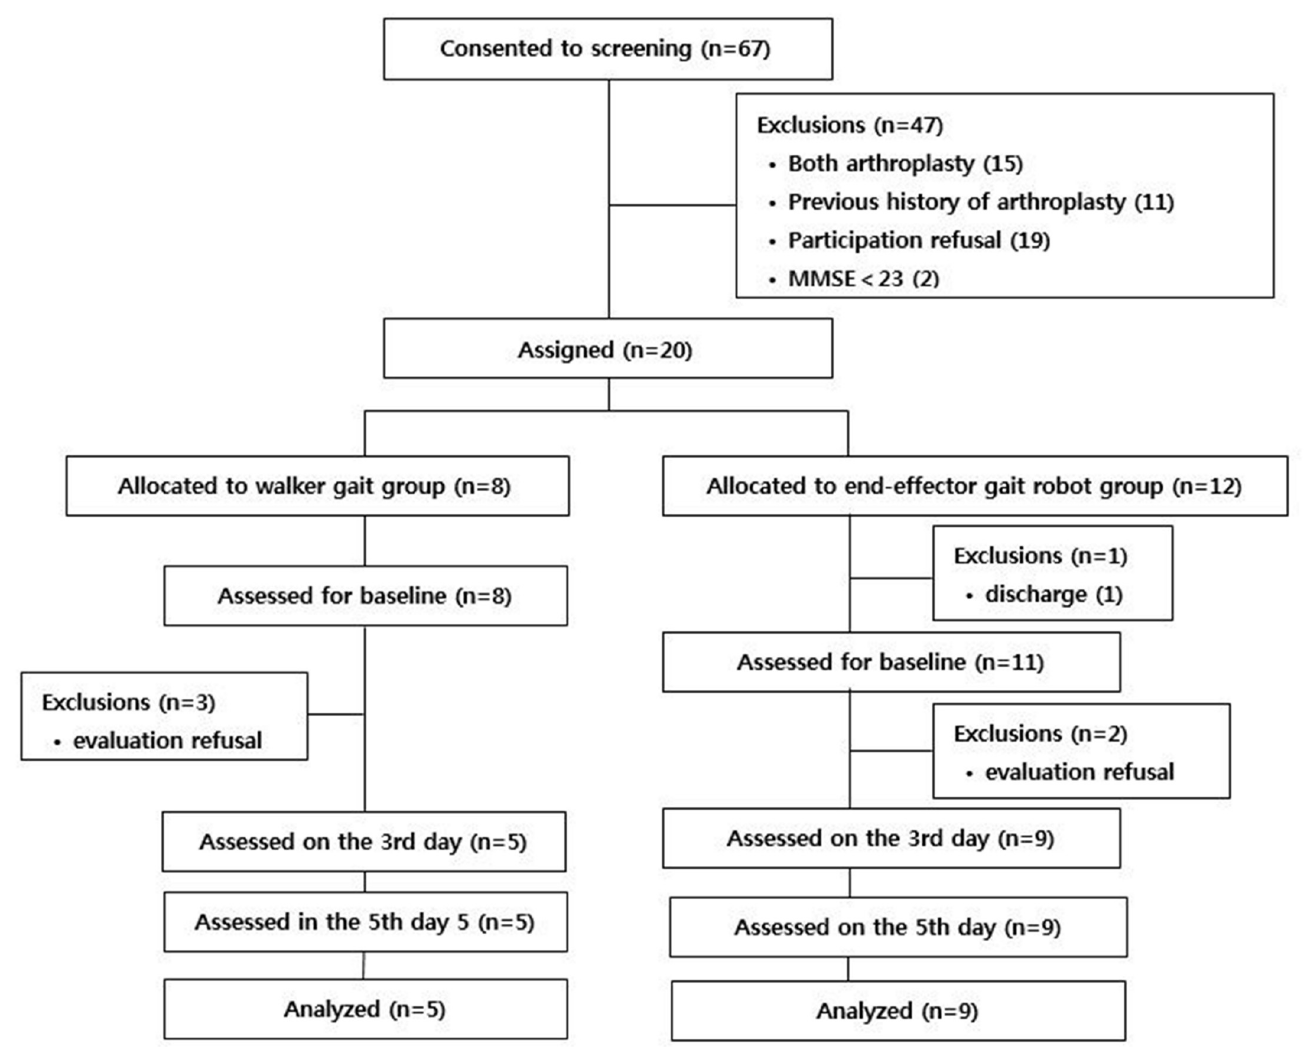
Fig 1. The flow diagram. (MMSE; Mini-Mental State